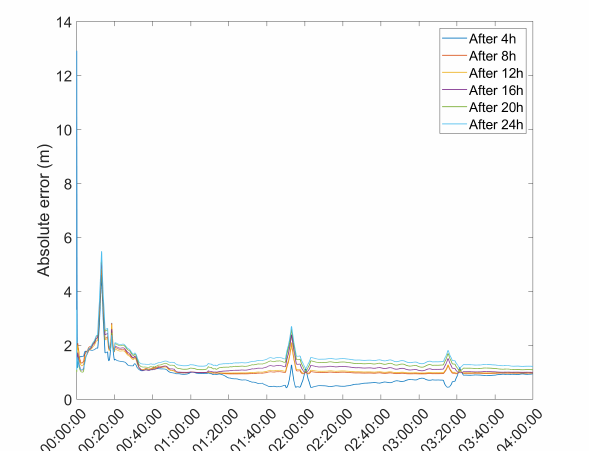
Figure 12. Rover position error with base station position obtained with EKF and averaged after a set number of hours.